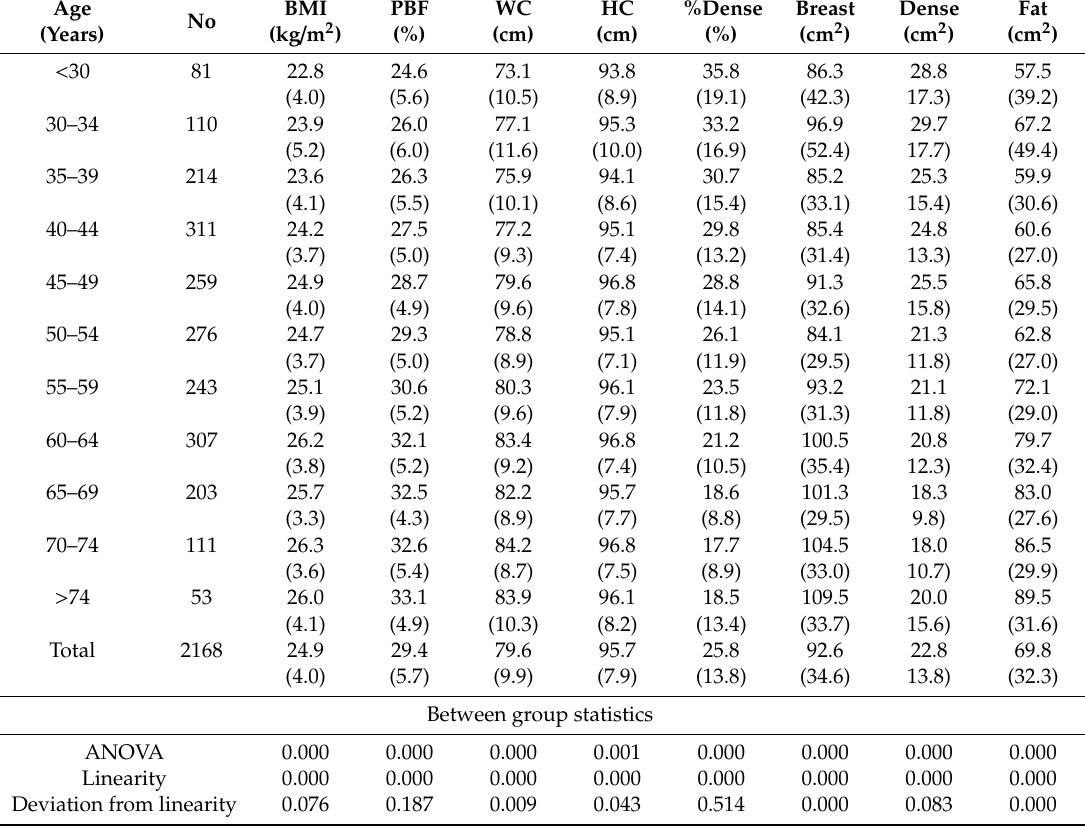
Table 1. Subject characteristics by age